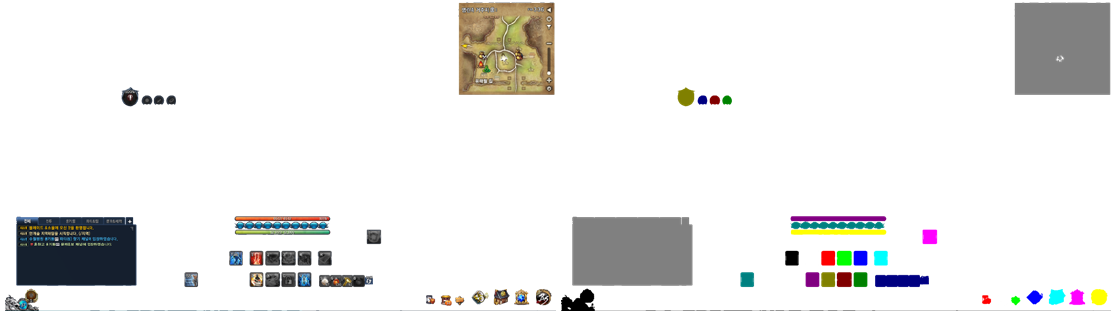
Figure 2. Extracted UIs ( left ), monochrome processed UIs ( right